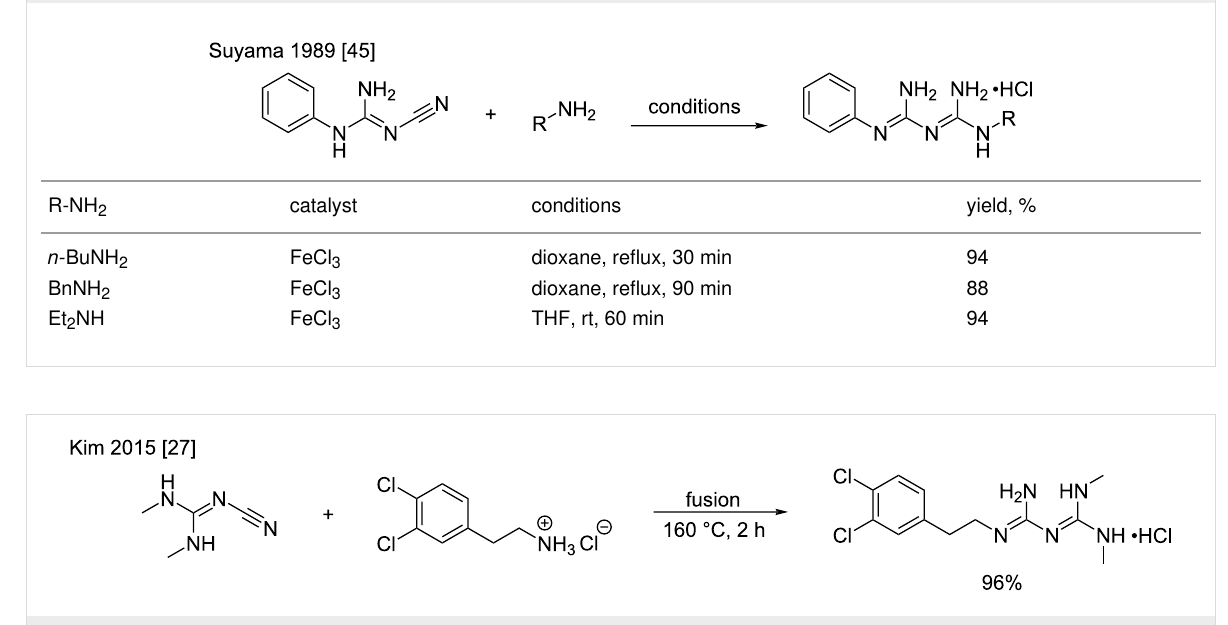
Table 1: Application of different Lewis acids for the reaction of amines with arylcyanoguanidines.